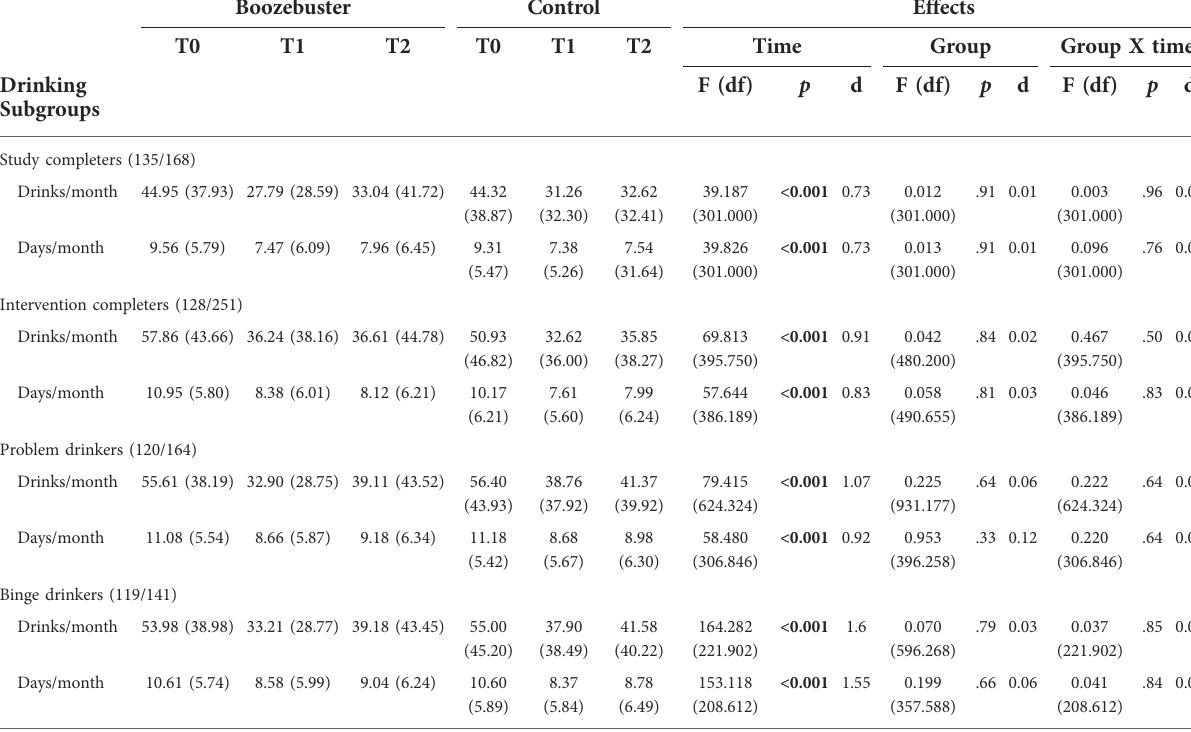
TABLE 4 Sub-group analyses on the effect of Boozebuster app on primary outcome